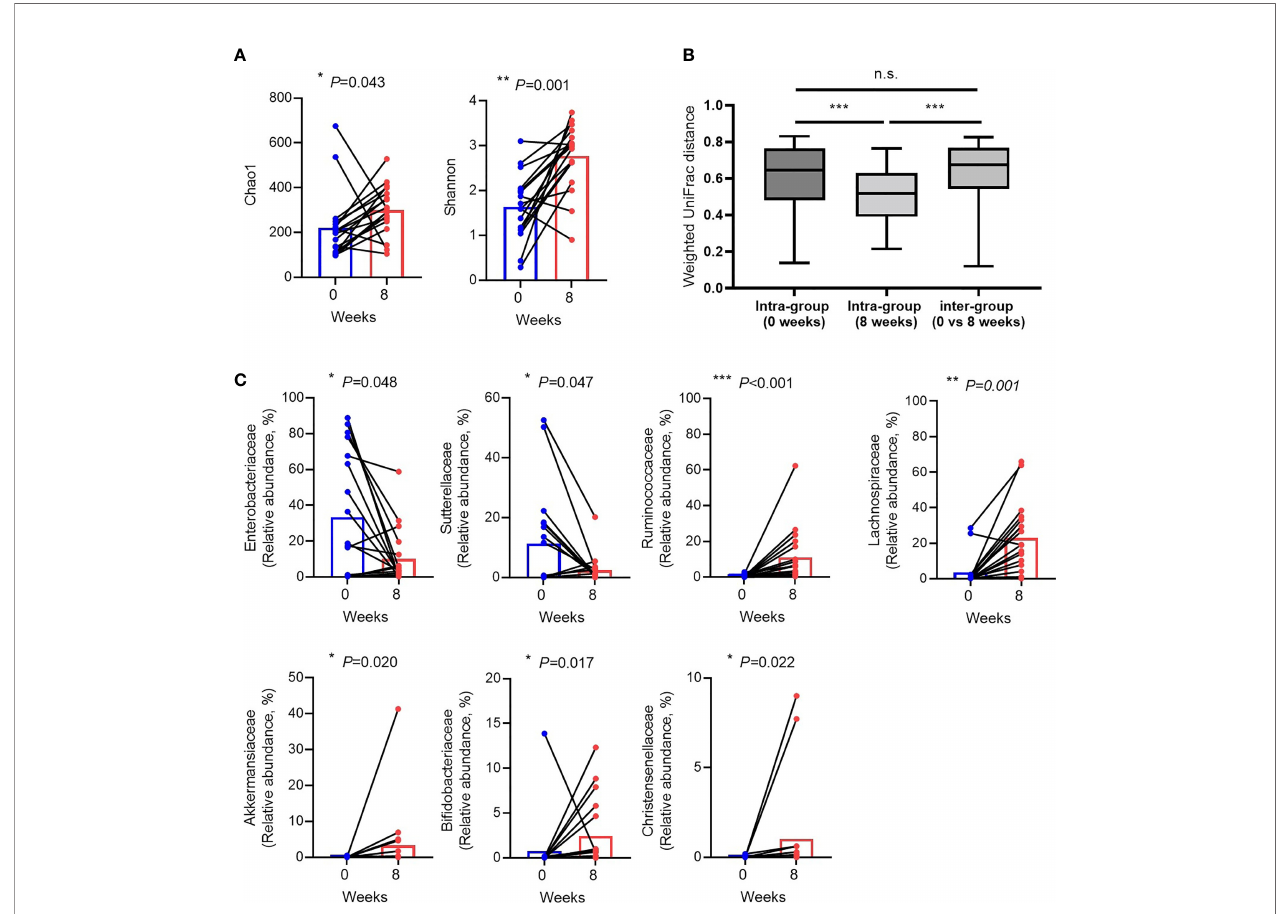
FIGURE 2 | Changes in the gut microbiota between Clostridioides dif fi cile infection and recovery after eight weeks. (A) Alpha diversity. (B) Weighted UniFrac distance. (C) Relative abundances of individual bacteria that were signi fi cantly different between Clostridioides dif fi cile infection and recovery. Blue dots indicate C. dif fi cile infection state (0 week), red dots indicate recovery after eight weeks, and black lines represent changes in the same patient. n.s, not signi fi cant; *P < 0.05, **P < 0.01 and ***P < 0.001 (Wilcoxon signed rank test and Mann-Whitney U